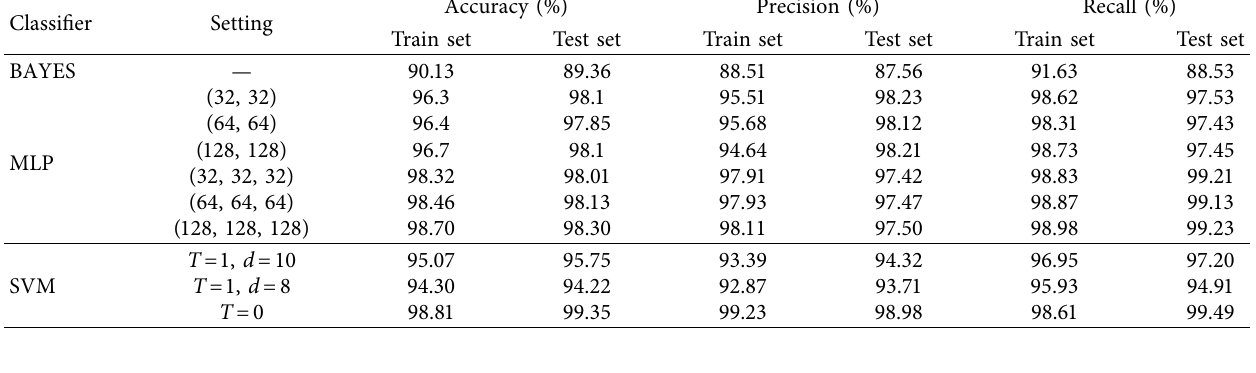
Table 2: Fatigue detection results among different